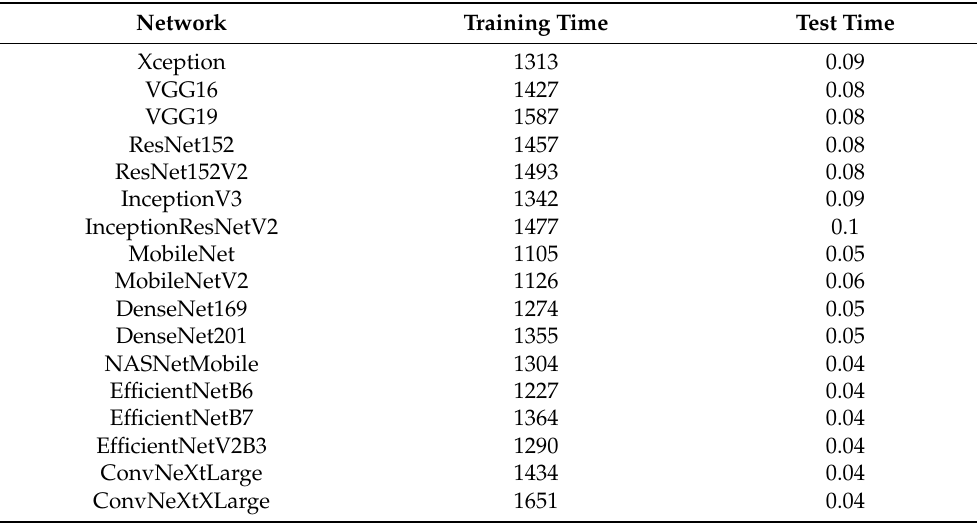
Table 5. Training and test times in seconds. Training time refers to training using the complete dataset. Test time refers to the time it took for the model to process one image after it was trained. Network Training Time Test